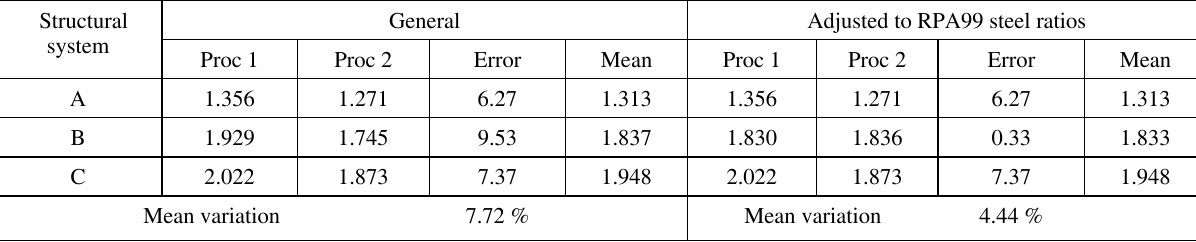
Table 5. Period amplification coefficient α without considering site